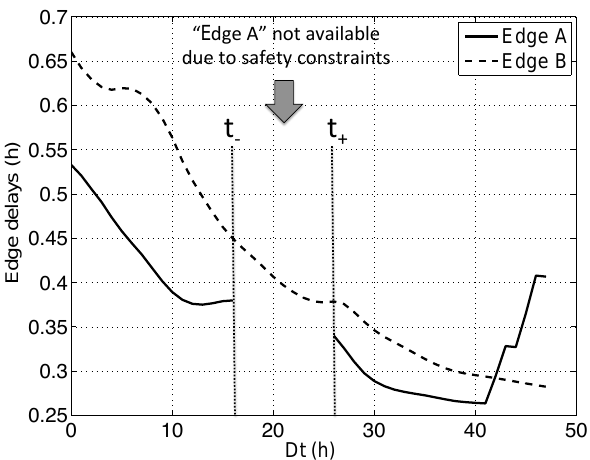
Figure 2. Examples of time-dependent edge delays a jk (t) . Here, FIFO condition Eq. (10) holds wherever a jk (t) is continuous (note that the y range is about 1 / 100 of the x range). The vertical dotted t ,t lines indicate the range of time (cid:49)t elapsed since departure, [ − + ] during which one of the edges is not available due to the naviga- tional safety constraints.